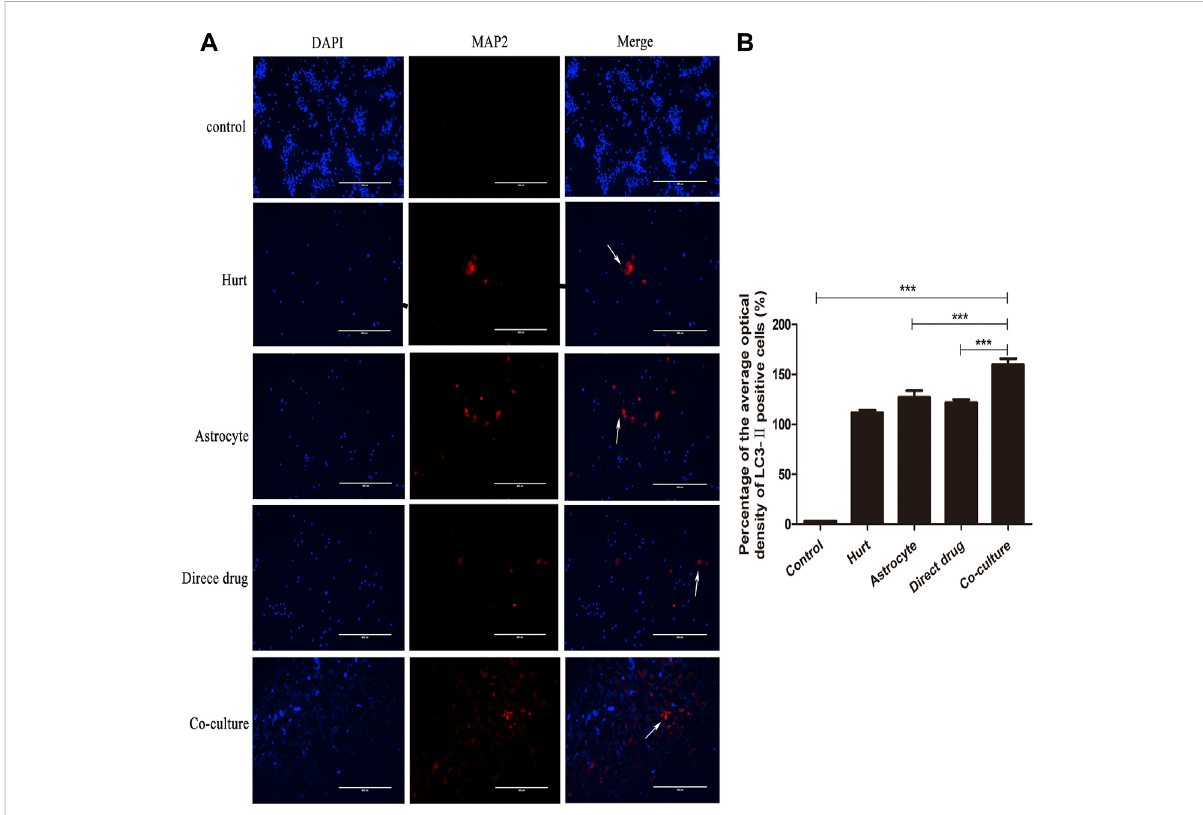
FIGURE 11 TFHL enhances autophagy of injured SMNs. (A) Under ×10 magni fi cation, the autophagy expression in SMNs of each group was observed by LC3- Ⅱ Immuno fl uorescence, with scale bars = 400 μ M. DAPI was a nuclear stain with blue fl uorescence; LC3- Ⅱ was a related protein with red fl uorescence; Merge was a composite image of the former two. (B) The comparison of the average optical density ratio of LC3- Ⅱ in each group. All data are expressed as the mean ± SD. Differences among groups were determined with one-way ANOVA followed by a least-signi fi